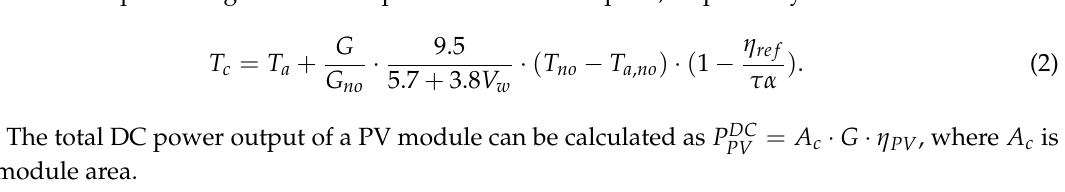
Table 1. Constant model